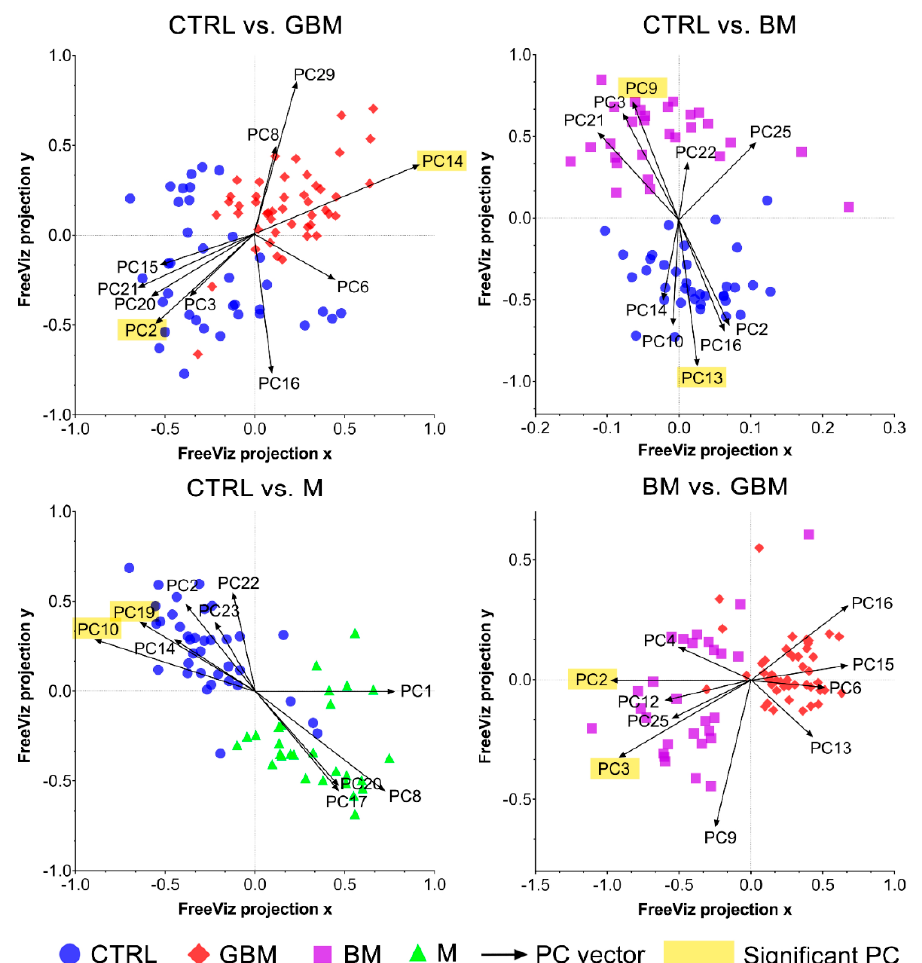
Figure 6. FreeViz projections of pairwise comparisons. Analysis of the PCA-transformed data using the FreeViz method yielded four graphs. Different dots and colors represent the patient groups and healthy controls. Black vectors represent the PCs. In each graph, only the 10 most relevant PC vectors were plotted. For each comparison, PCs marked with a yellow background indicate the 2 most significant PCs.